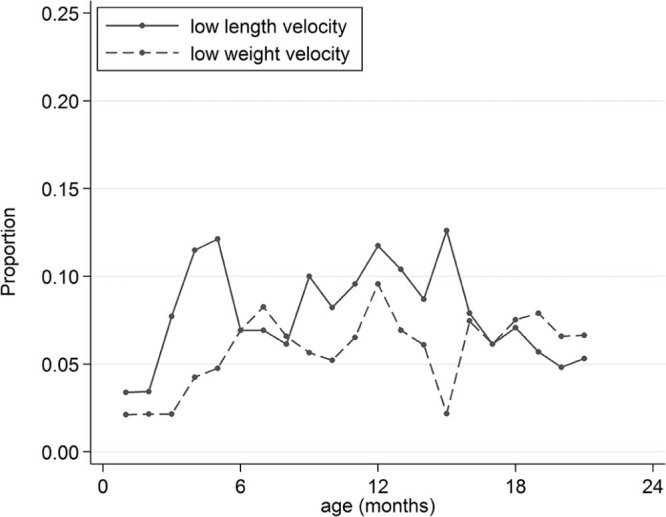
Proportion of 240 children enrolled in the MAL-ED study, Nepal, having a low weight or length velocity z score (<−2) according to age. All velocity z scores use a 3-month increment and are plotted at the beginning of the growth period, eg, a velocity z score plotted at 3 months is the velocity for the period from 3 to 6 months.